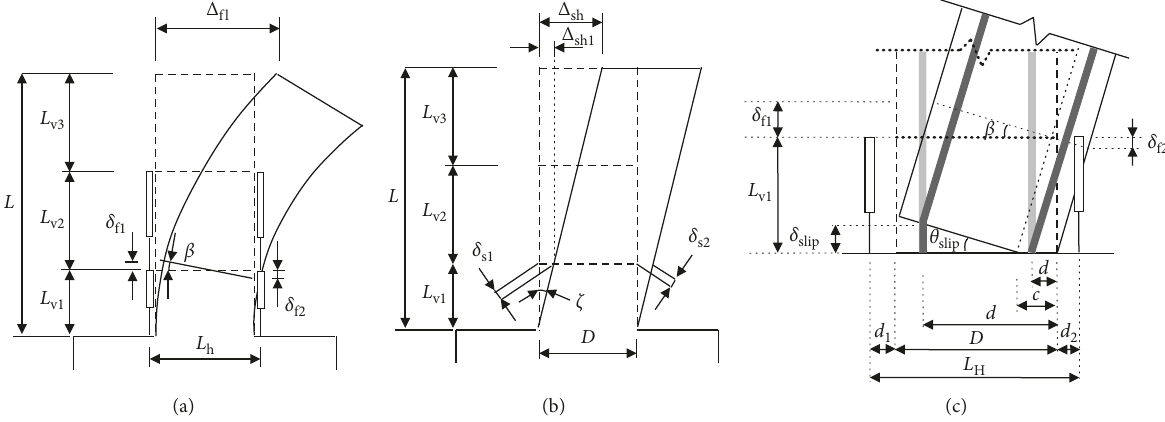
Figure 7: LVDT measurements for (a) flexure deformation, (b) shear deformation, and (c) yield penetration deformation.